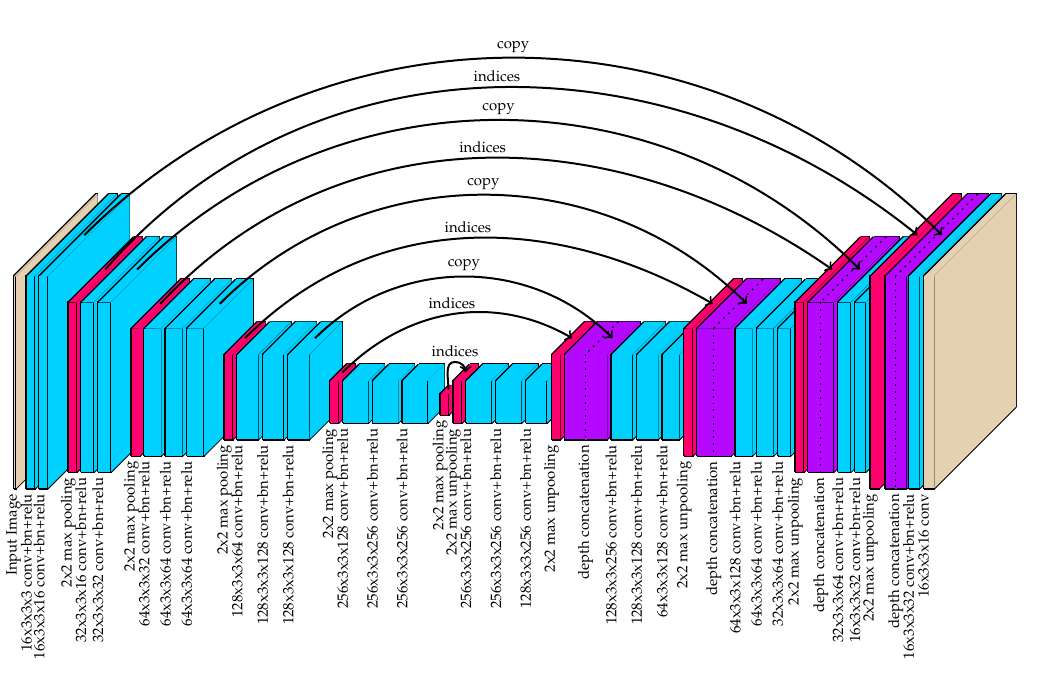
Figure 5. The hourglass-shaped network used by the proposed method to convert images to 16-channel image-space instance detection